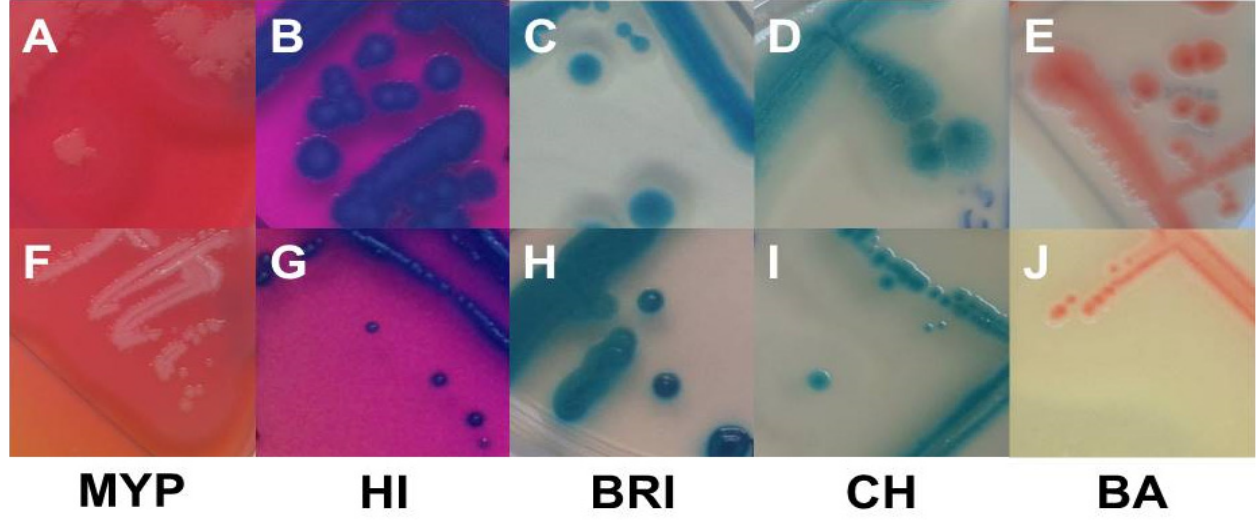
Figure 2. Typical ( A – E ) and atypical colonies ( F – J ) of Bacillus cereus sensu lato on MYP agar (A (BCG 6), F (BC 66)), ChromoSelect Bacillus agar (B (BC 30), G (BC 20)), Brilliance™ B. cereus agar (C (BC 2), H (BC 19)), CHROMagar™ B. cereus (D (BC 63), I (BC 2)) and BACARA ® agar (E (BC 50), J (BC 34)). Bluish-green colonies are the result of β -D-glucosidase reaction. Precipitation zones surrounding typical colonies are caused by phospholipase C reaction, while lack of mannitol fermentation results in